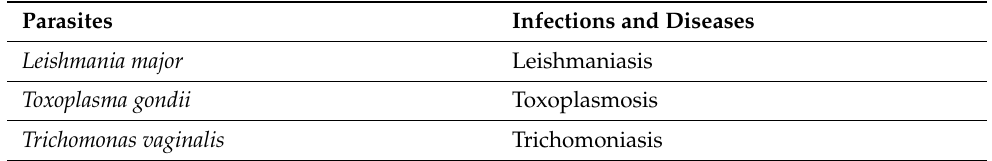
Table A3. A list of parasites species mentioned in the review and the diseases inflicted by